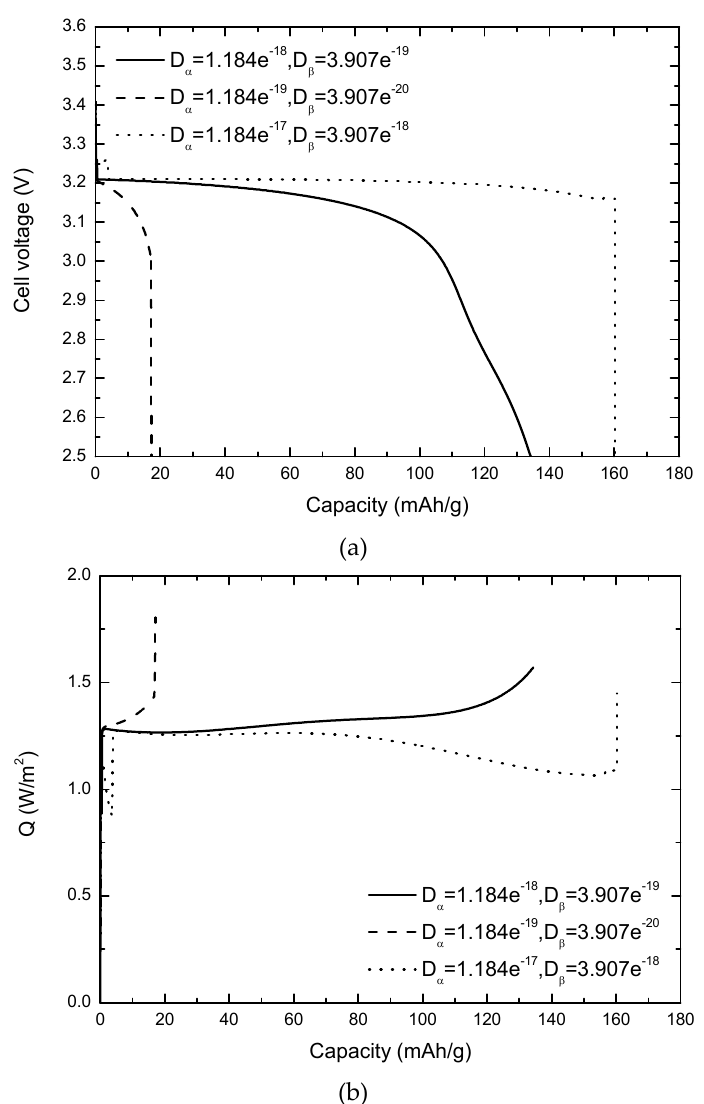
Figure 10. Effect of the lithium diffusivities of the α and β phases on ( a ) the discharge voltage curve and ( b ) the overall heat generation at a 1 C rate.